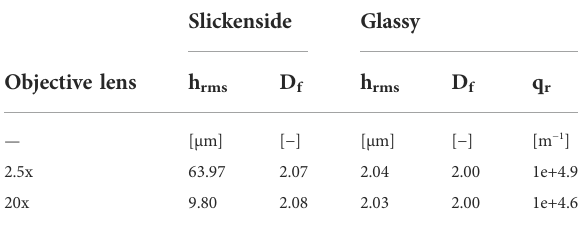
TABLE 1 Parameters which characterize the roughness of the fracture